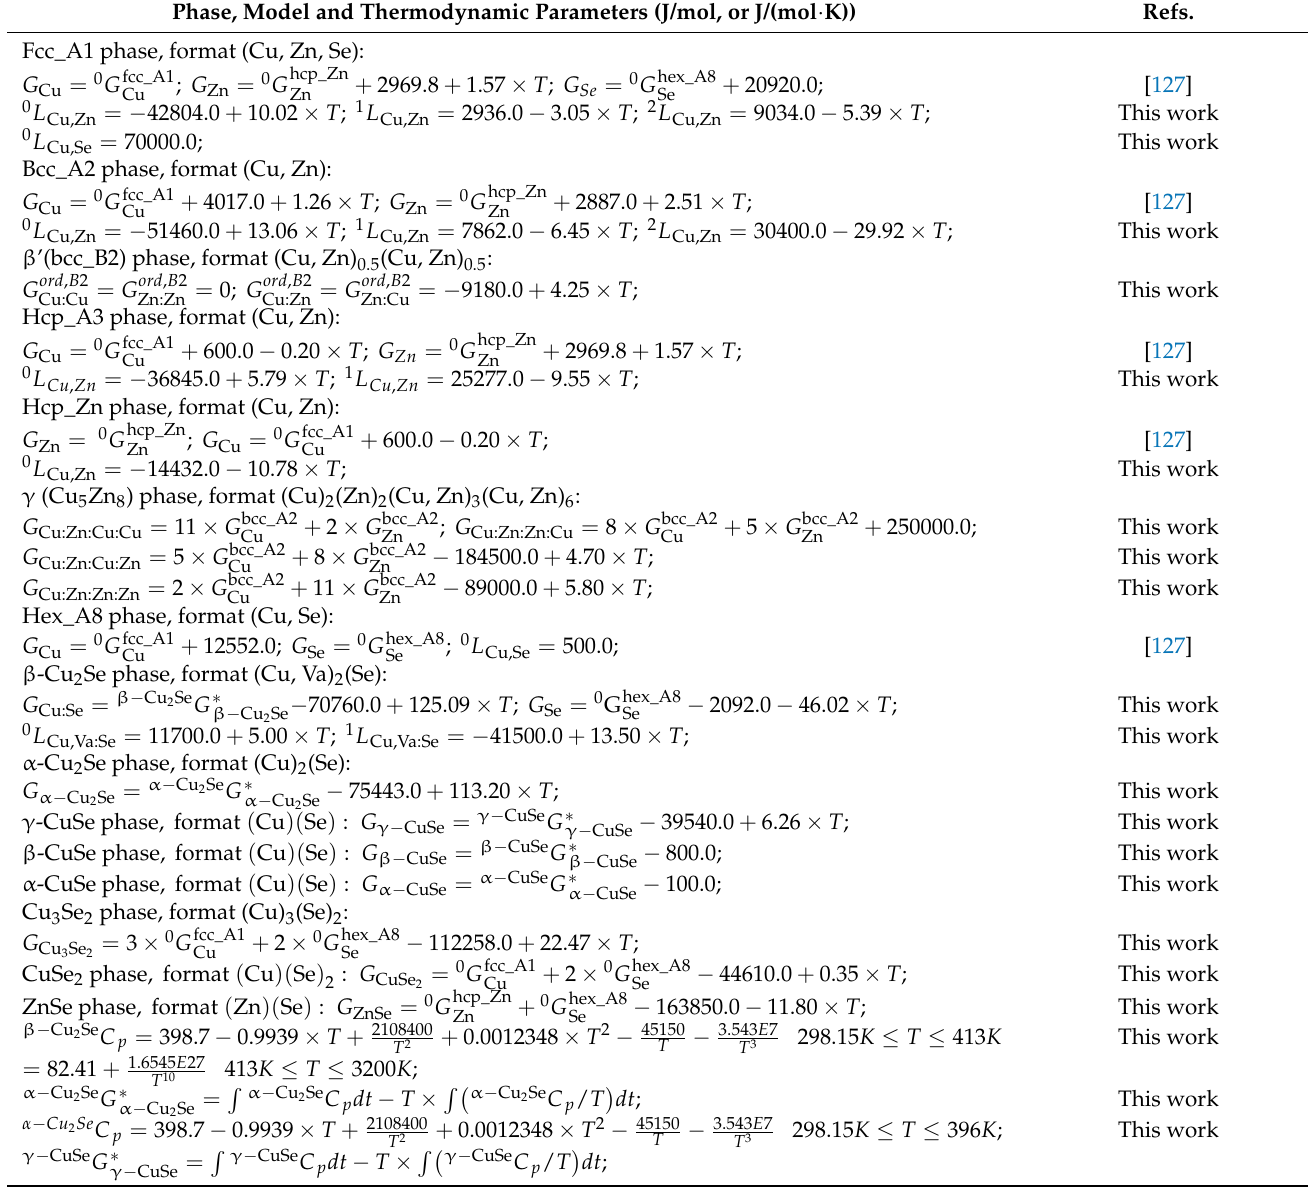
Table 6. Optimized thermodynamic parameters of the solid solutions and compounds in the Cu-Zn, Cu-Se and Zn-Se binary